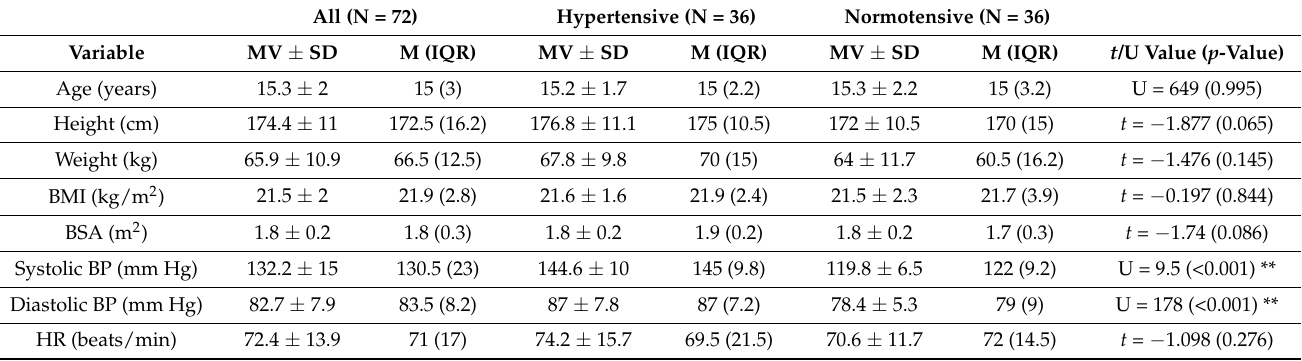
Table 1. Anthropometric and body composition parameters of the study